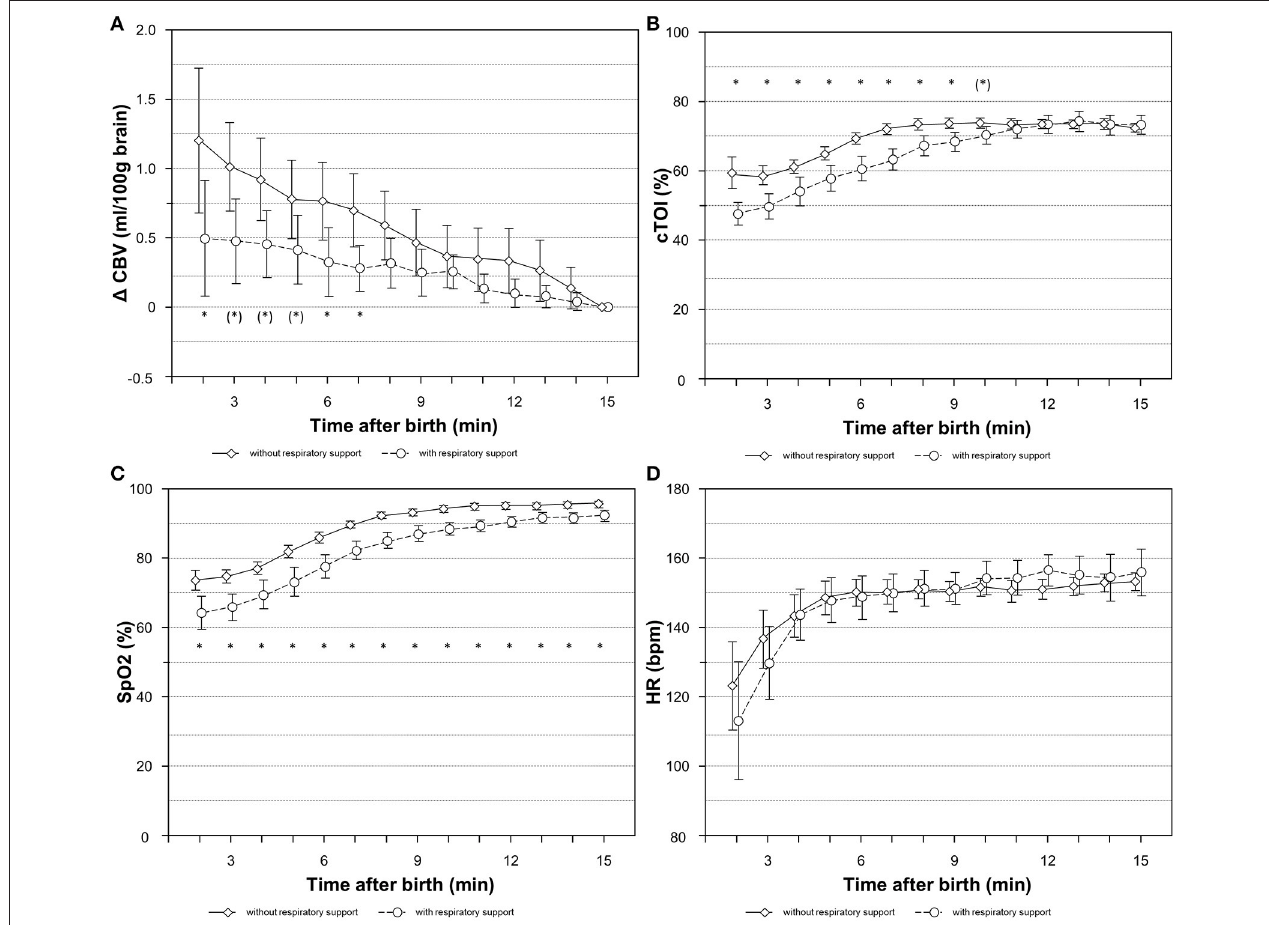
FIGURE 1 | Courses of 1 CBV (A) , cTOI (B) , SpO 2 (C) , and HR (D) during the first 15min after birth in newborn infants with and without respiratory support. Values are mean (95%CI); * p < 0.05, (*) p < 0.1, significances are calculated for group comparisons for each minute. bpm, beats per minute; CBV, cerebral blood volume; cTOI, cerebral tissue oxygenation index; HR, heart rate; SpO 2 , arterial oxygen